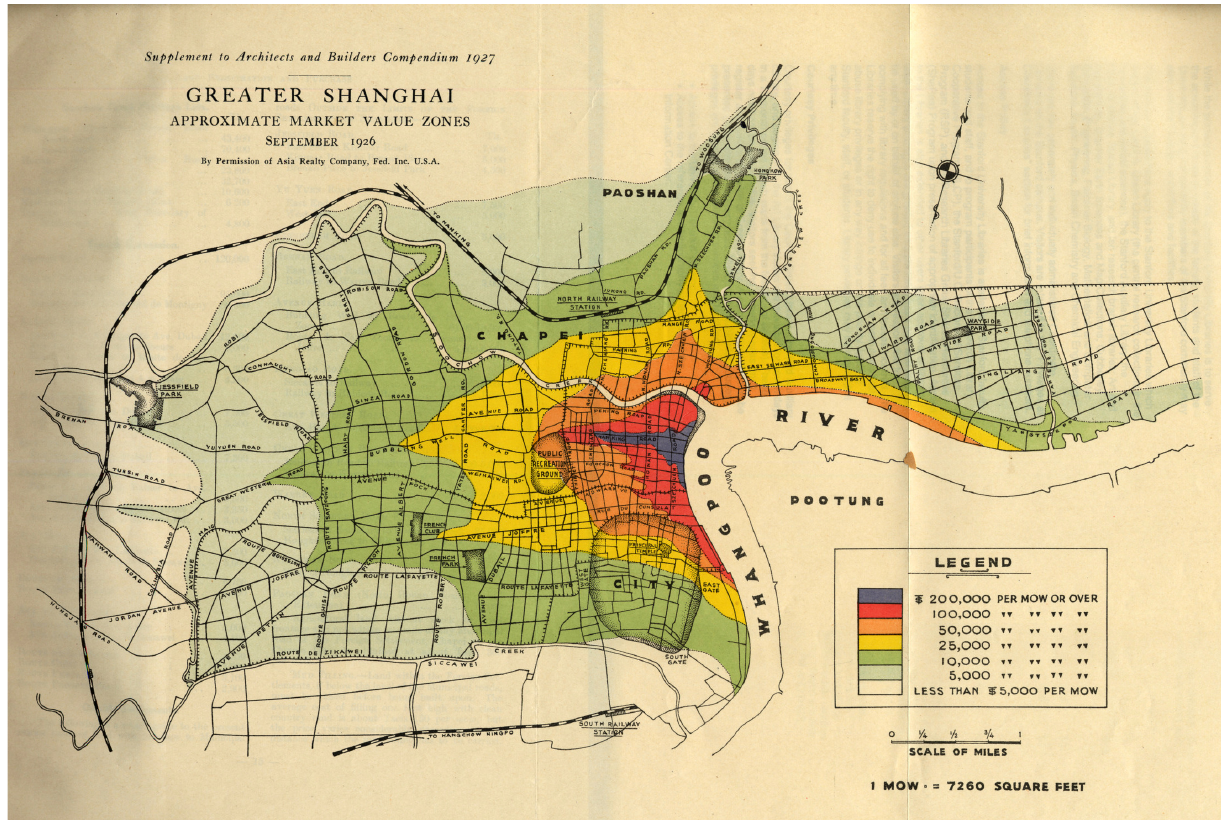
Figure 7. During the period of foreign concessions, Shanghai’s Nanjing Road area and Bund (both in purple) became the new heart of the city, and housed multiple headquarters, foreign banks, and shipping companies. The former foreign con‐ cessions used to be closed to local Chinese citizens. Source: Brooke and Davis